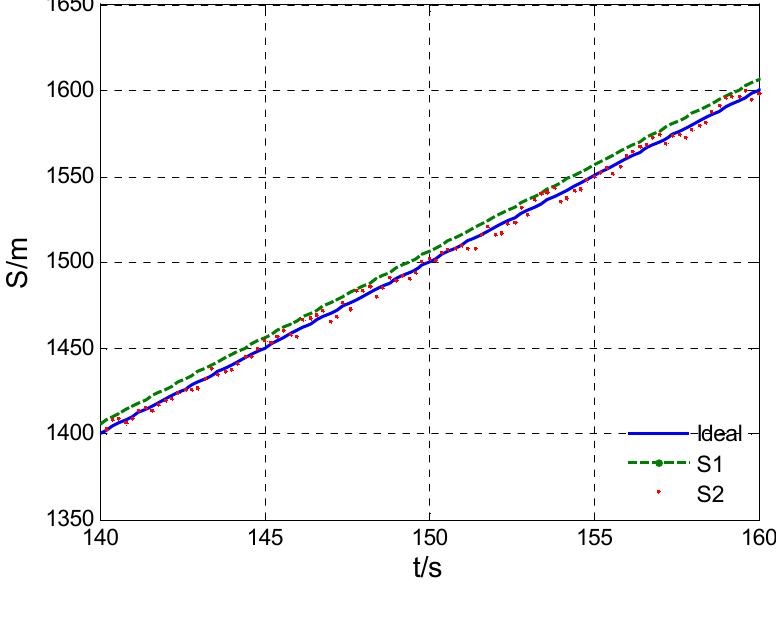
Figure 3. GPS calculated distance histories vs . theoretical distance